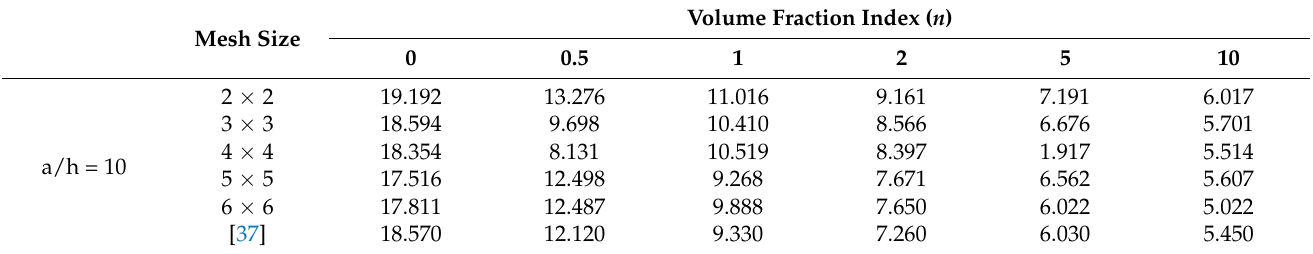
Table 2. Convergence study of the Al/Al 2 O 3 plate.